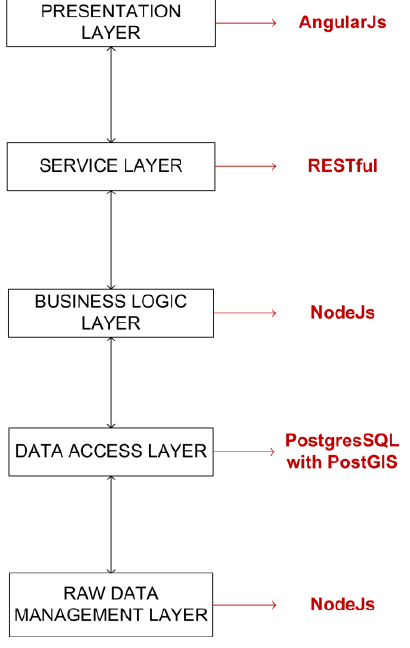
Figure 4. Architecture adopted for the management of 3D